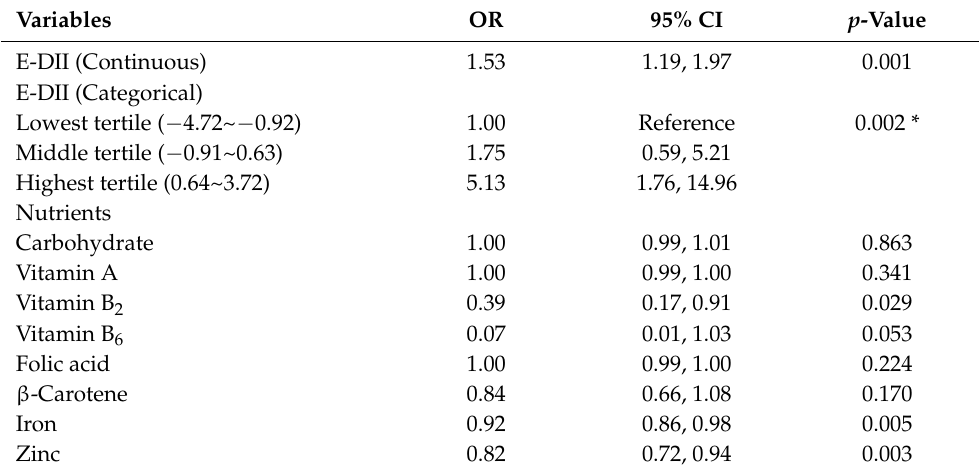
Table 4. Association between the E-DII and its components with depressive symptoms ( n =